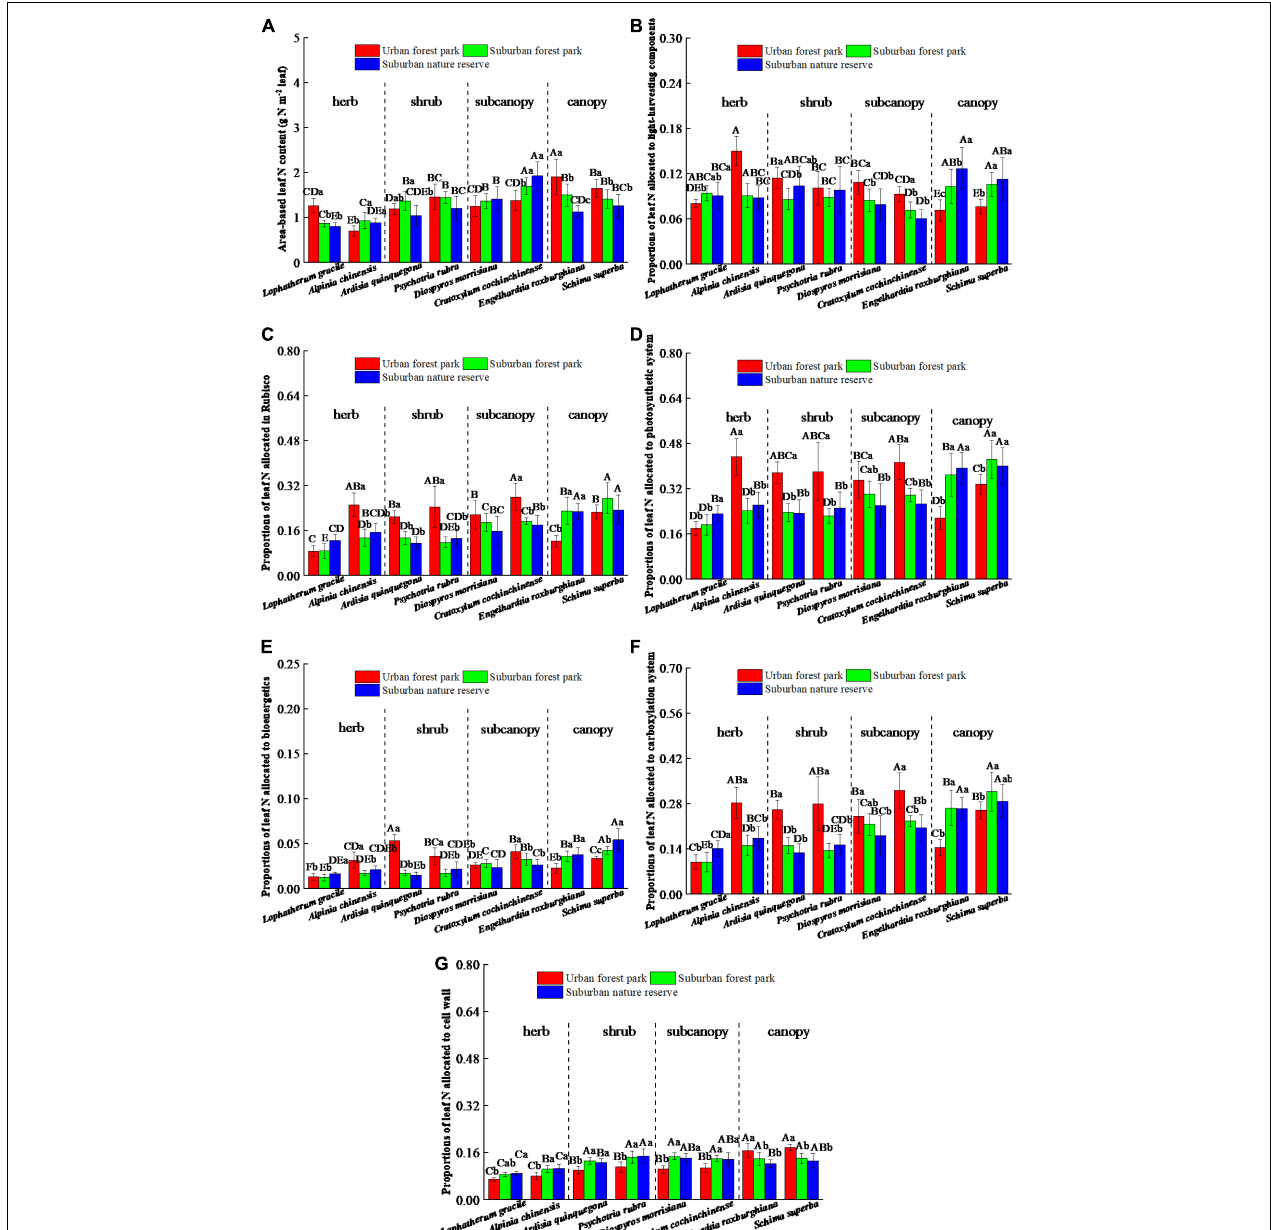
FIGURE 5 | Effects of growth environment on (A) area-based leaf N content and proportions of leaf N allocated to the (B) Rubisco, (C) bioenergetics, (D) light-harvesting components, (E) photosynthetic system, (F) carboxylation system, and (G) cell wall of eight plant species. The lowercase letters reveal the significant differences ( P < 0.05 ) of the same species among different growth environments, and the capital letters reveal the significant differences ( P < 0.05 ) of different species in the same growth